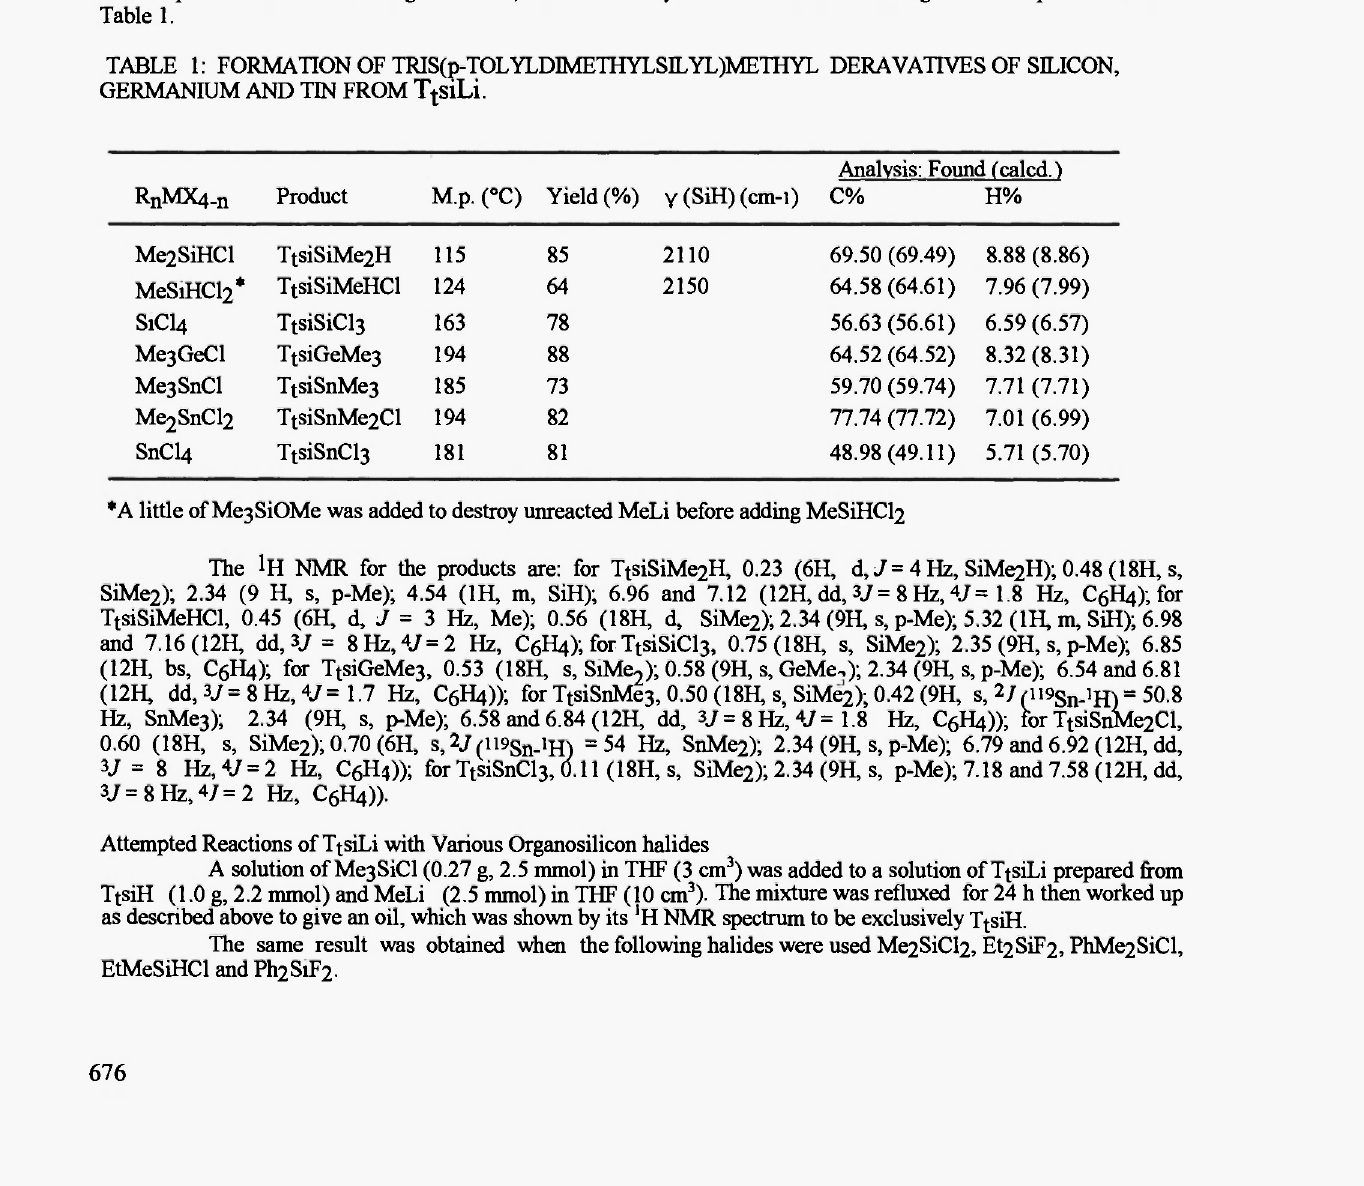
TABLE 1: FORMATION OF TMS(p-TOLYLDIMETHYLSILYL)METHYL DERAVATIVES OF SILICON, GERMANIUM AND TIN FROM T t